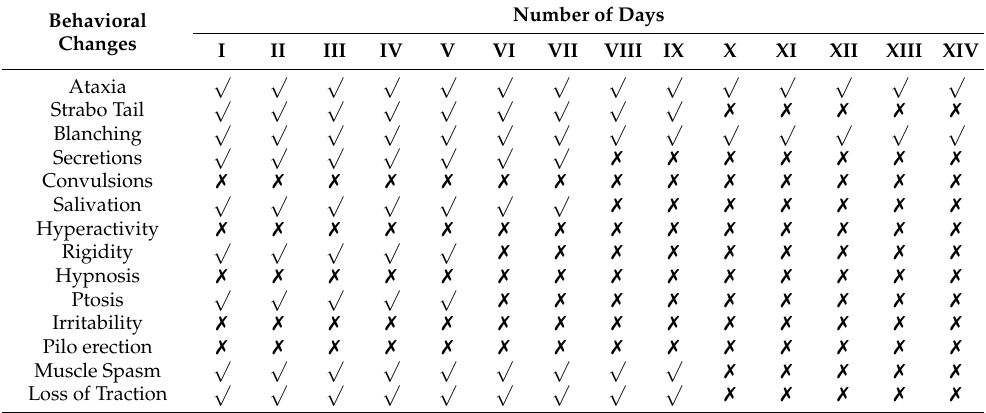
Table 6. Acute toxicity study showing effect of P.aAf (150 mg/Kg/p.o.) on behavioral and physiolog- ical characteristics of